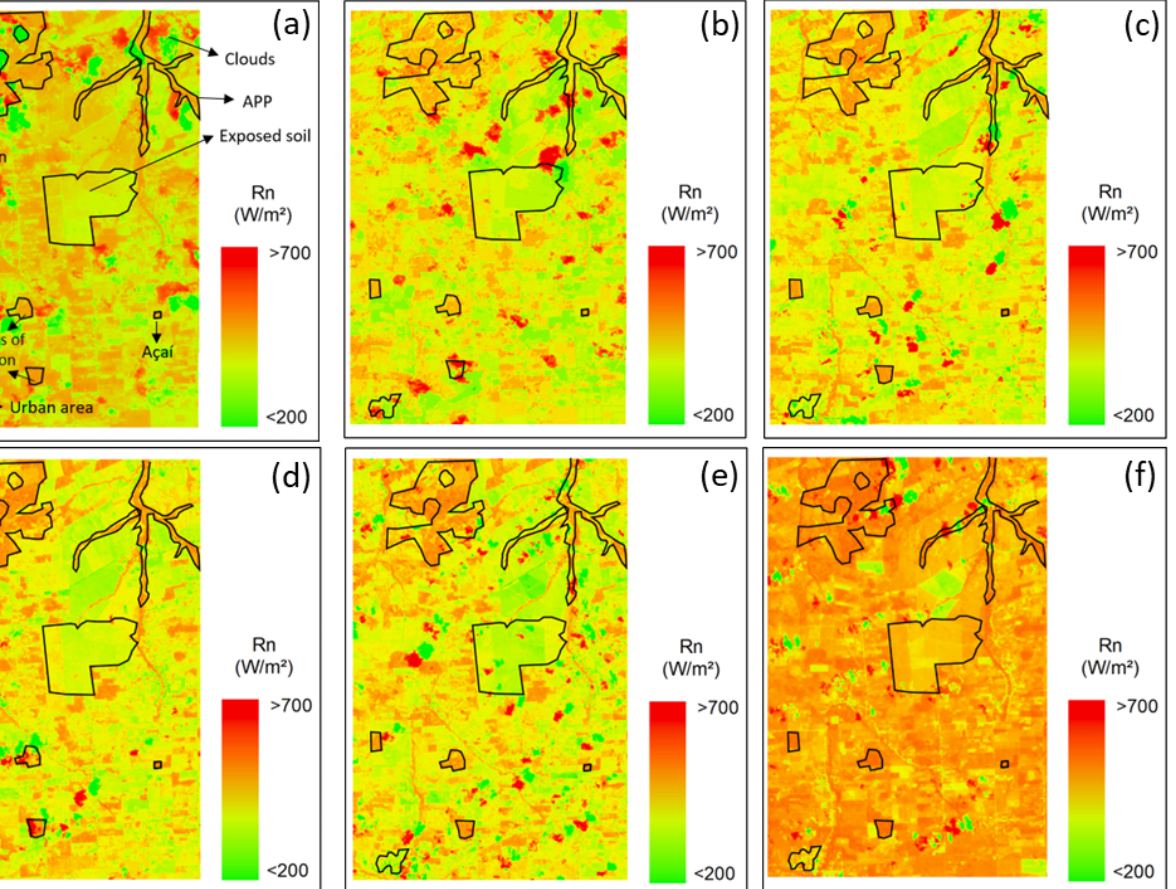
Figure 6. Temporal distribution of radiation balance (Rn) on 20 November 2017 ( a ), 22 December 2017 ( b ), 31 May 2018 ( c ), 7 June 2018 ( d ), 26 June 2019 ( e ), and 29 August 2019 ( f ). On 20 November 2017, the estimated surface was highest from the central region down (Figure 7a). On 22 December 2017, during the rainy season, it was more stable (Figure 7b). The estimated temperature on 7 June 2018 varied from 20.07 °C to 32.3 °C with an average of 24.6 °C (Figure 7c). On 7 June 2018, the surface temperature estimate, at the point referring to the micrometeorological tower, was 25.6 °C (Figure 7d). The estimation obtained through the algorithm indicated a minimum surface temperature value of 22.3 °C and a maximum of 34.2 °C on 29 August 2019 (Figure 7f).